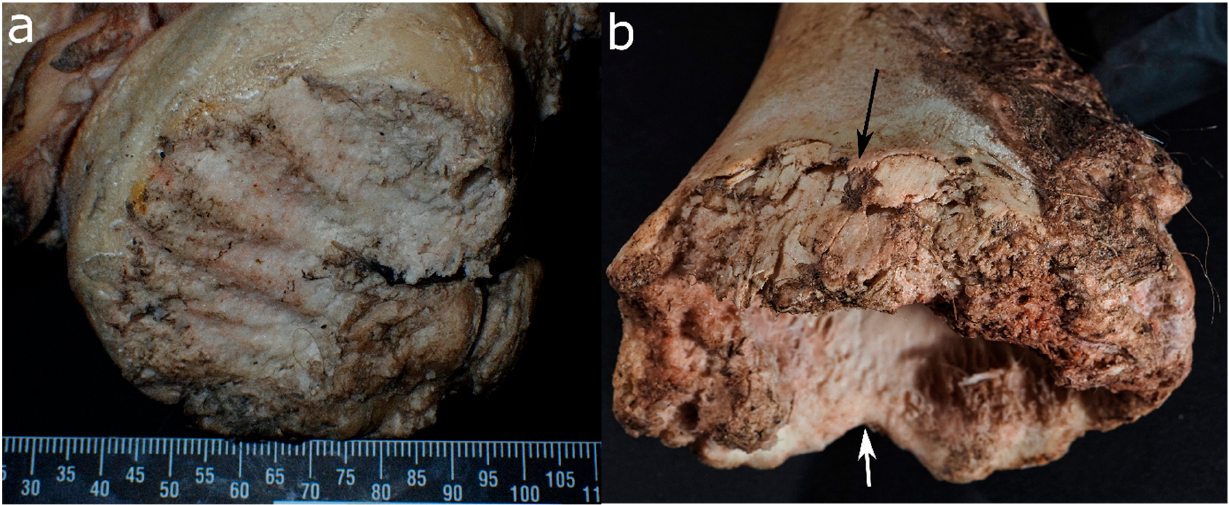
Figure 4. Cow bones gnawed by a brown bear in Switzerland (Tierpark Goldau): ( a ) condyle of the femur with large furrows and ( b ) gouged out end of a long bone with irregular and crushed margins (both arrows) that in some places appear rounded (white arrow).